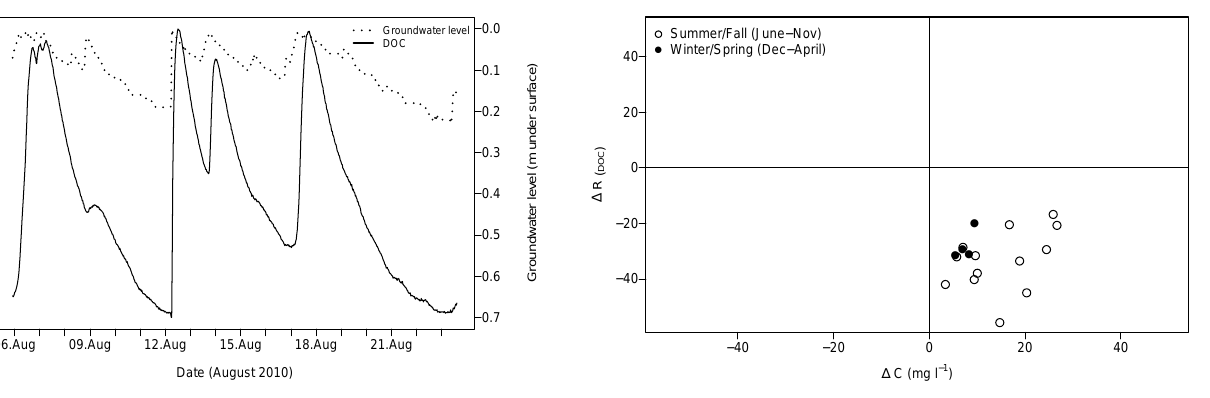
Fig. 4. Parameters of hysteretic loops in different time periods. For the calculation of 1R (DOC) and 1C (mgL − 1 ), see Sect.